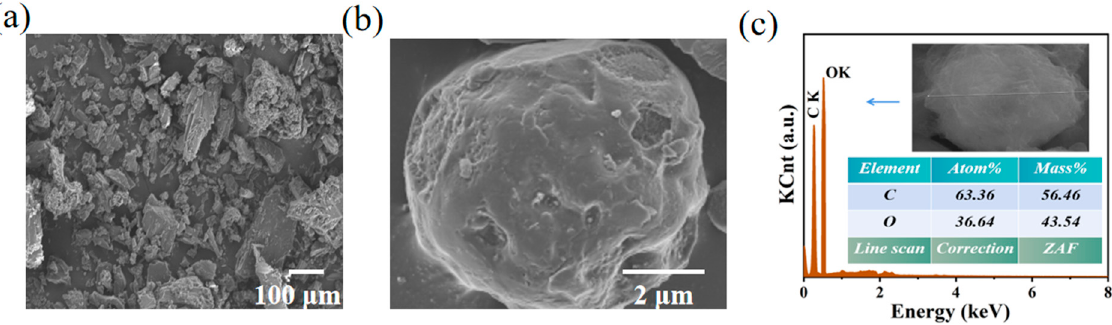
Figure 3. ( a , b ) SEM images, ( c ) EDS spectra of the YC/D-mannitol ss-PCM.